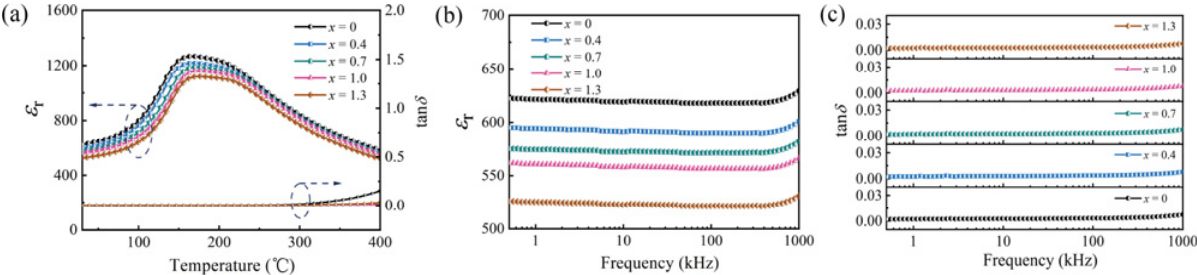
Fig. 4 (a) Temperature-dependent ε r and tan δ of all samples at 1 kHz. The frequency-dependent (b) ε r and (c) tan δ of all samples at room